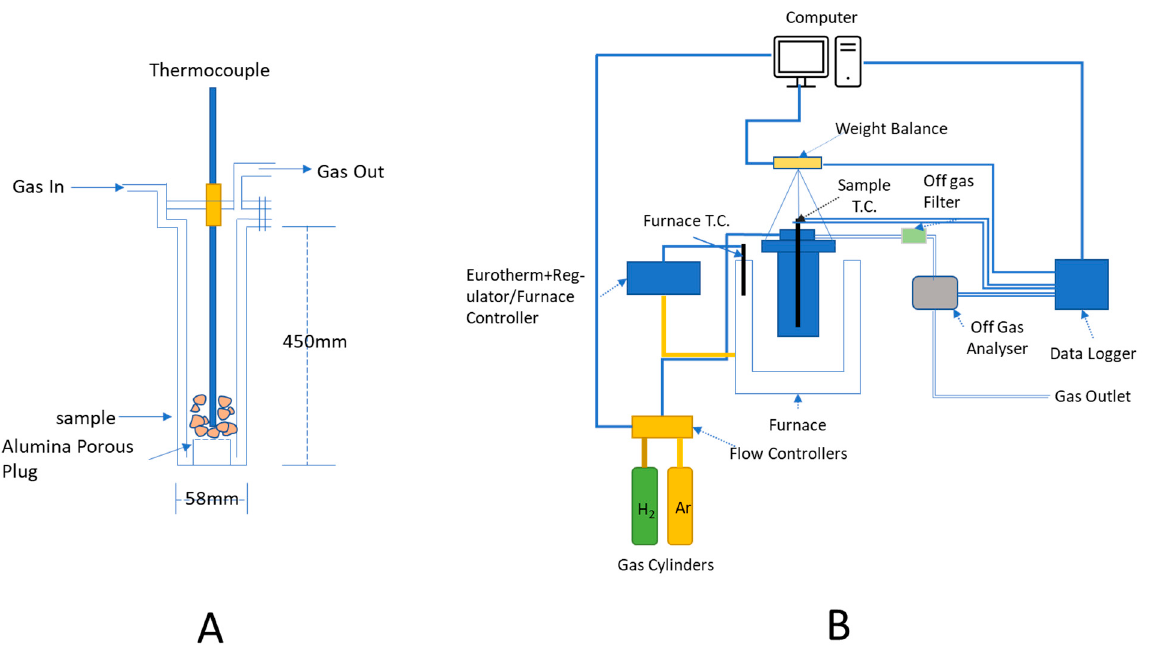
Figure 2. Schematic of thermogravimetric furnace setup, crucible ( A ) overall set up furnace ( B ).